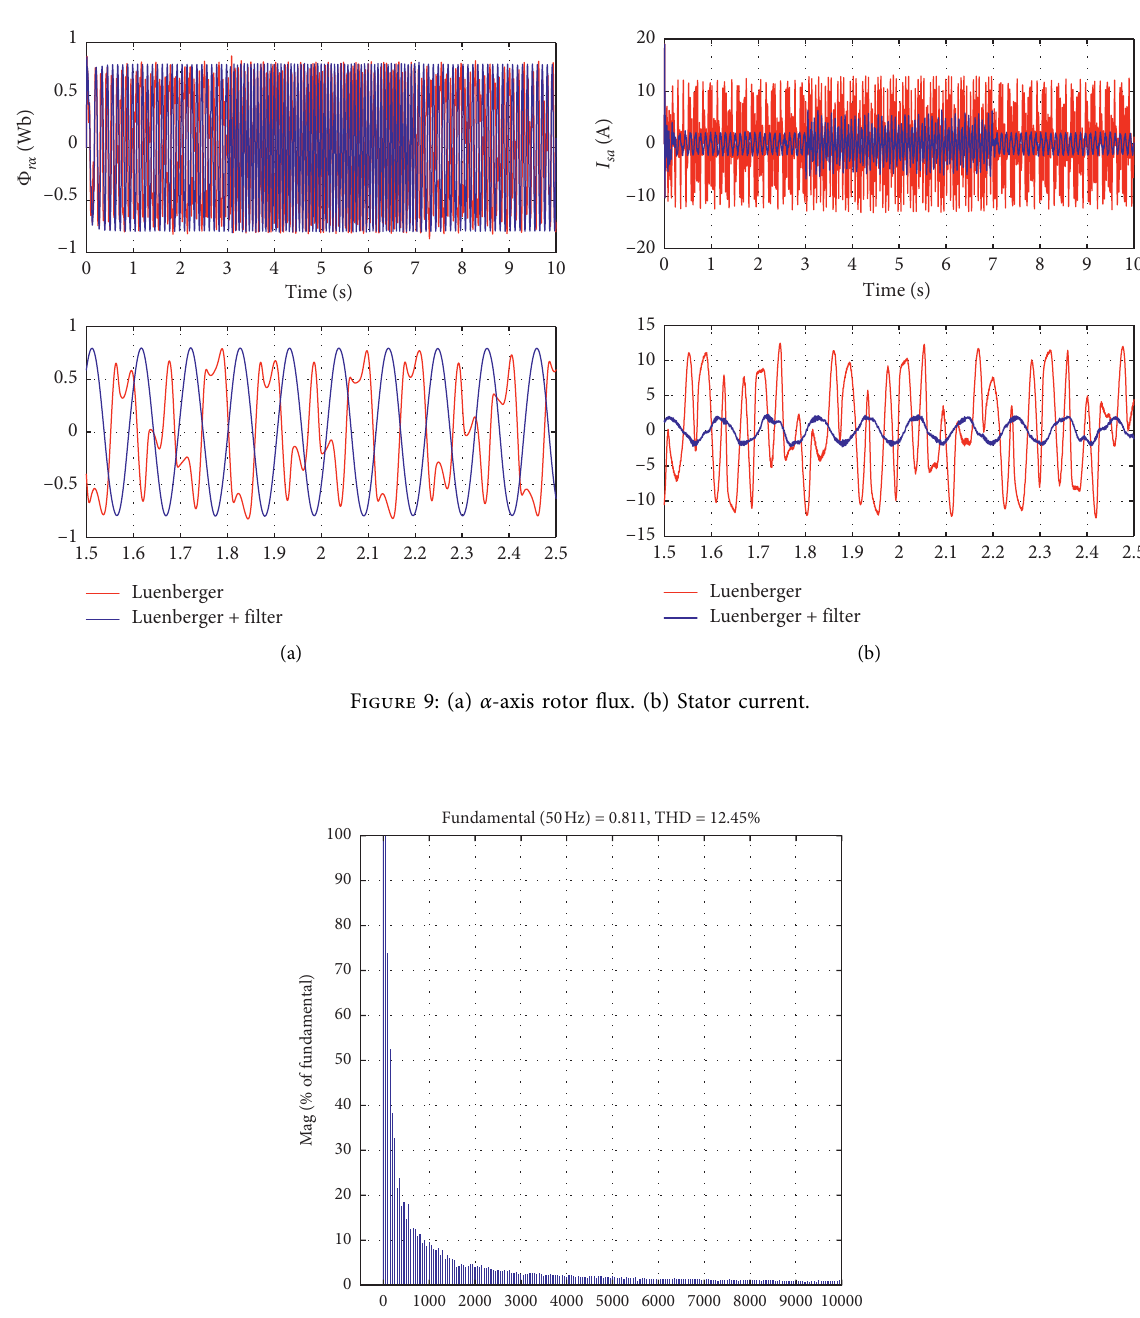
Figure 10: Spectrum analysis of stator current using only the full-order